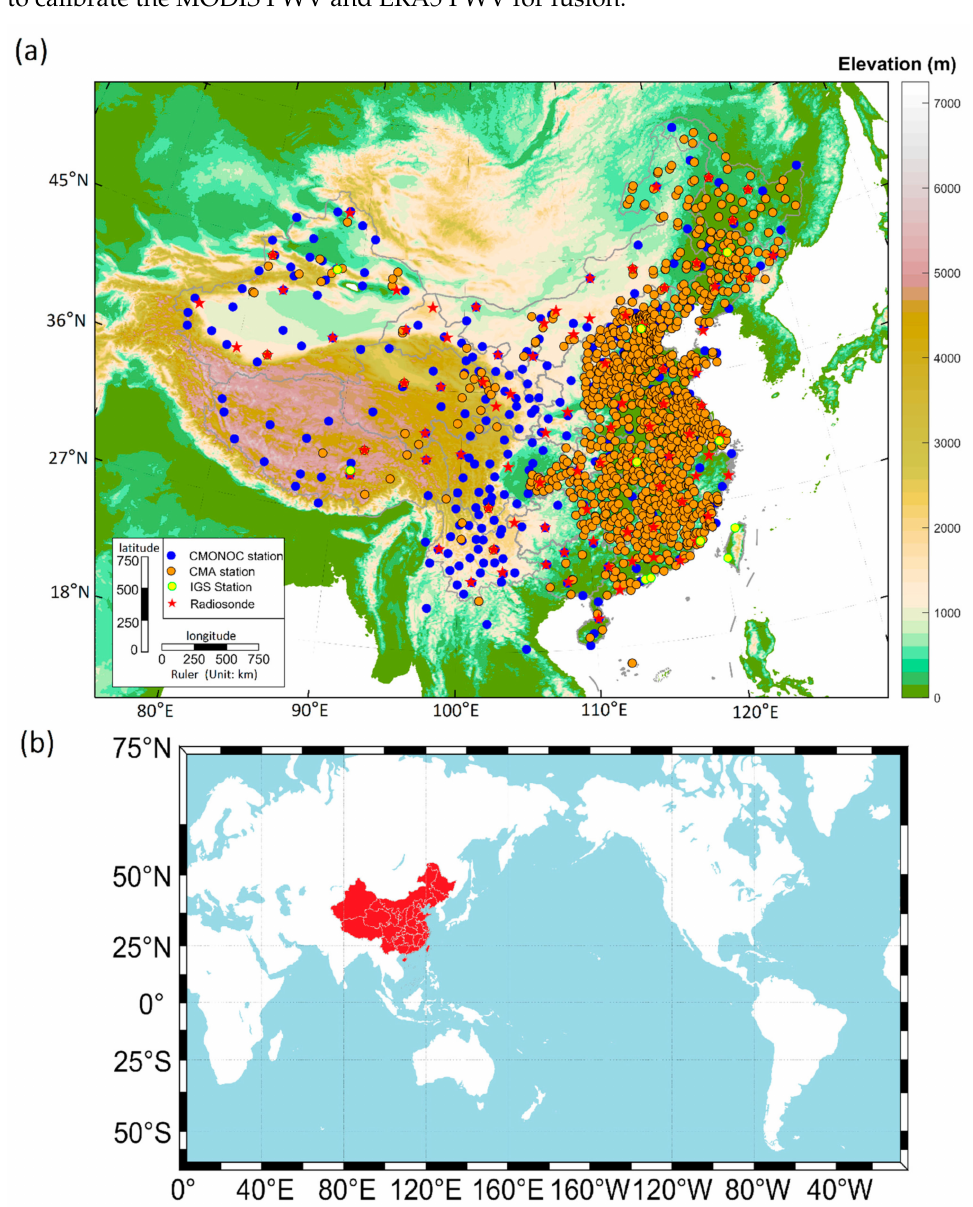
Figure 1. ( a ) Research area and the distribution of GNSS stations and Radiosonde stations; ( b ) the localization of study area (showing as red area) at a global